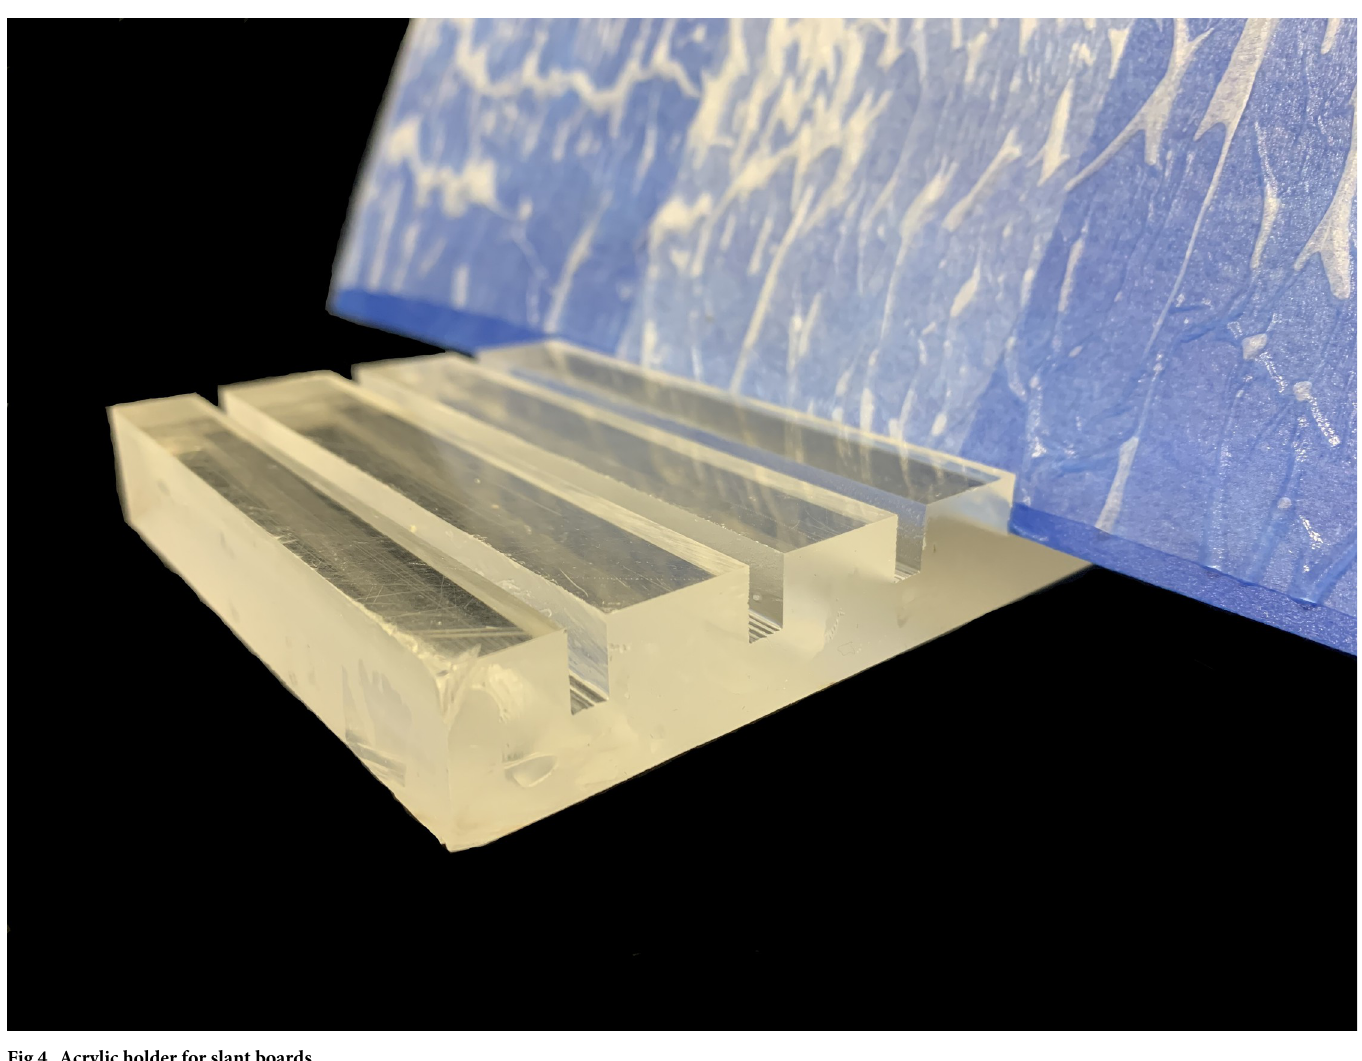
Fig 4. Acrylic holder for slant